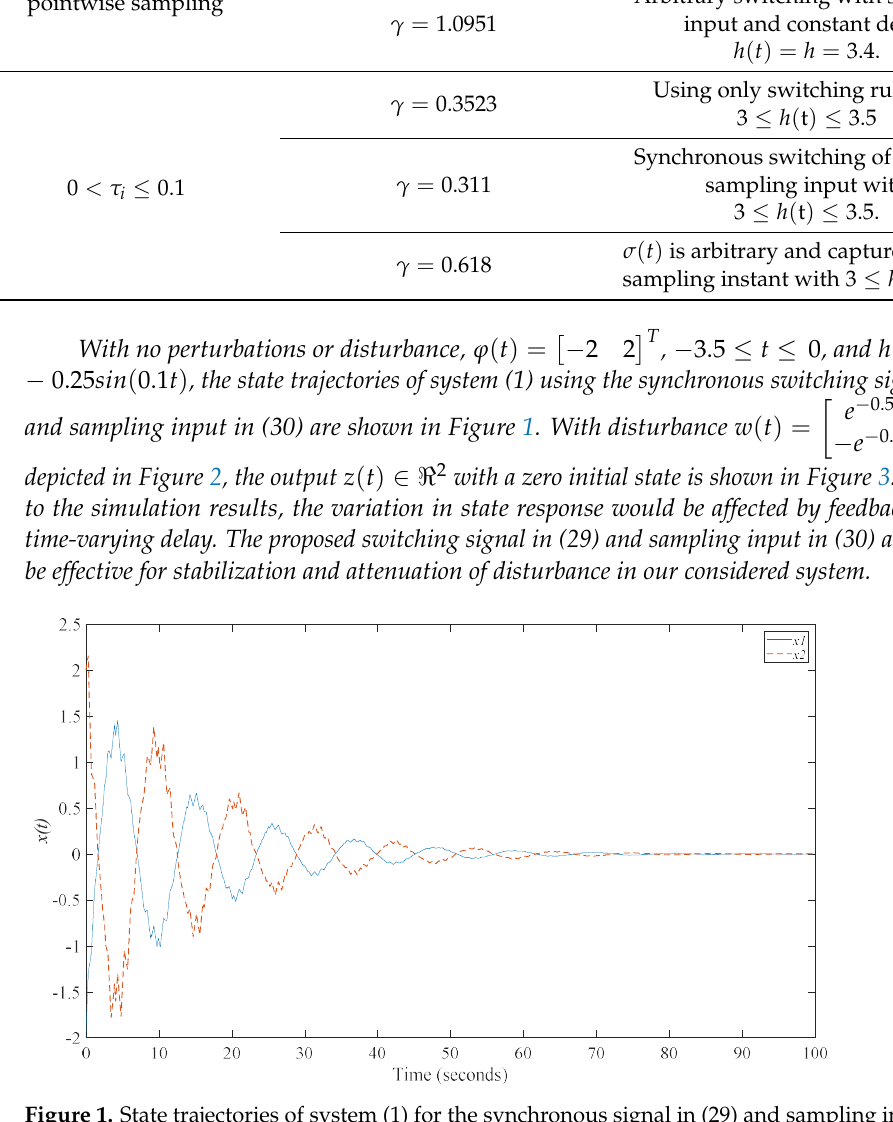
Figure 2. Disturbance input. Figure 3. Output of system (1) for the synchronous signal in (29) and sampling input in (30).